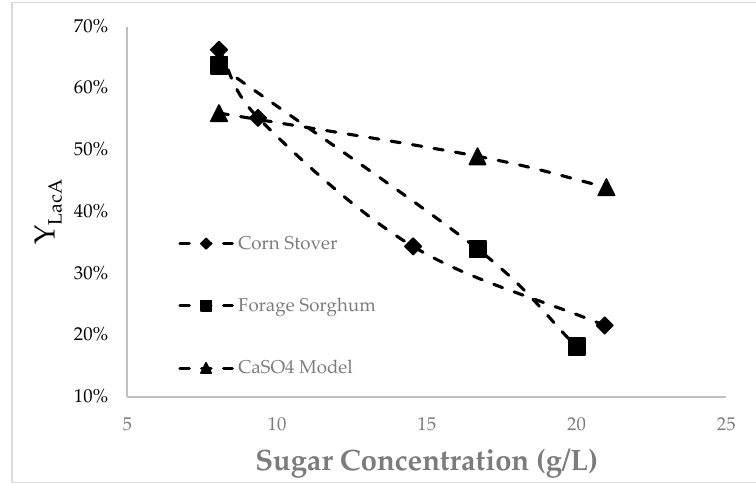
Figure 7. The sensitivity of lactic acid yield to the inlet sugar concentration at constant catalyst and solvent loadings for corn stover, forage sorghum, and model sugar solutions. Experiments were conducted at a reaction temperature of 200 °C, a catalyst concentration of 33 g/L, and a reaction time of three hours. The corn stover (pH 4.5) and forage sorghum (pH 5.8) solutions contained residual CaSO 4 from the acid hydrolysis process while the model solution was mixed with CaSO 4 to a pH of 5.8.